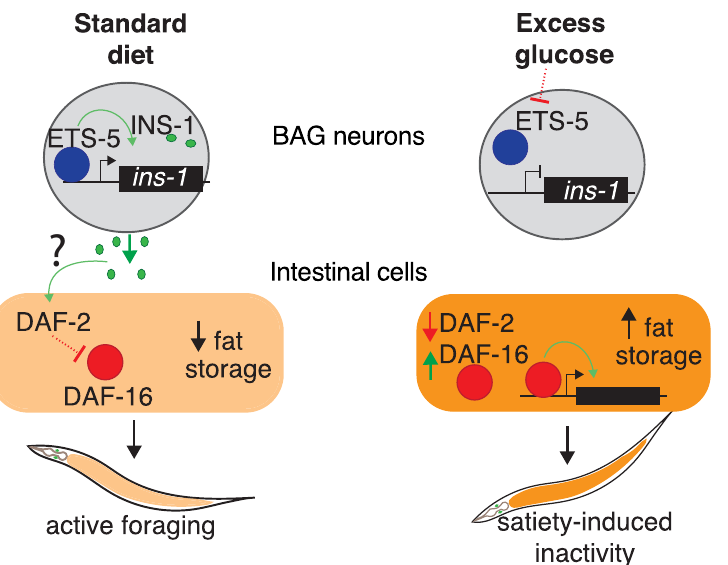
Fig 8. Model of the ETS-5/INS-1 regulatory module. Under standard food conditions, ETS-5 directly promotes ins-1 expression in the BAG neurons. INS-1 acts from the BAG neurons to reduce fat levels in the intestine by activating DAF-2, which inhibits DAF-16 activity. Reduced fat stores lead to increased foraging behavior. Worms that experience excess dietary glucose down-regulate ETS-5 and INS-1 levels in the BAG neurons. This suppression of ETS-5/INS-1 leads to decreased intestinal DAF-2 activity, and increased intestinal DAF-16 levels. DAF-16 then alters intestinal gene expression to promote fat storage and produces a satiety-induced reduction in foraging activity.